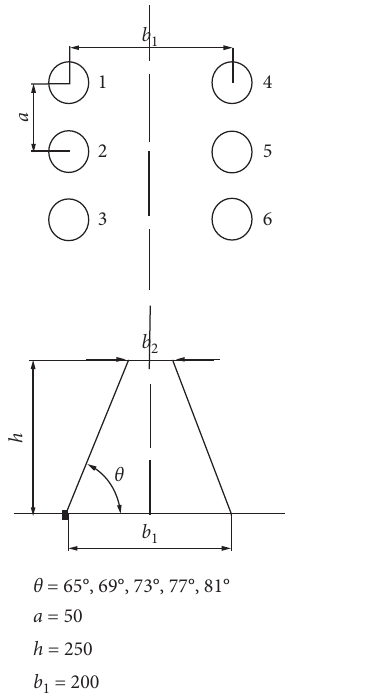
Figure 1: Layout of single-stage wedge cutting blast holes with different angles (unit: